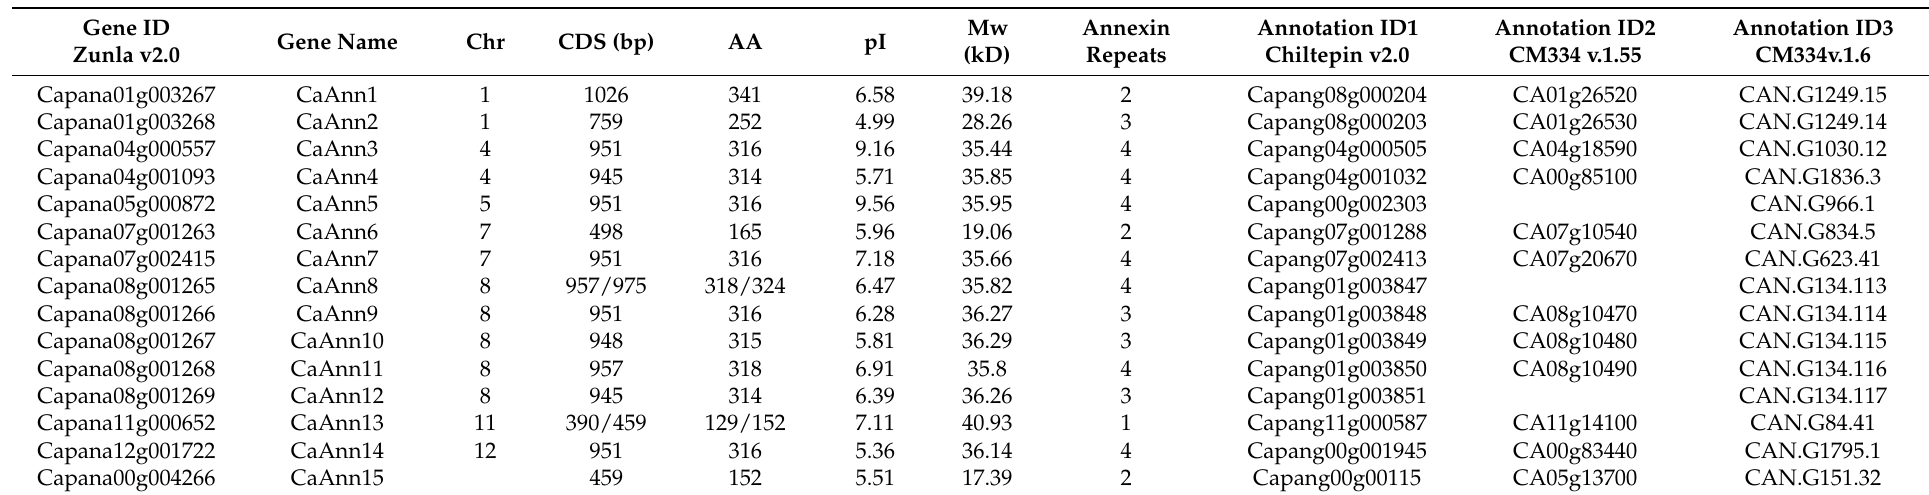
Table 1. List of annexin genes in